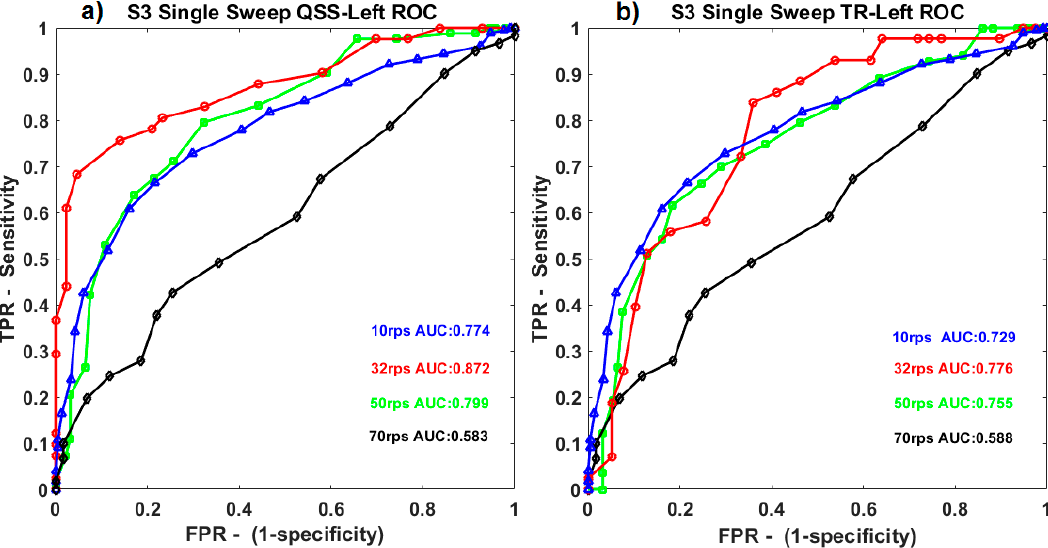
Figure 3. Subject 3 (S3) single sweep 0.5-second condition. ( a ) Left QSS-VEP receiver operating characteristic (ROC) curves and areas for all the rates are shown at the left. ( b ) Left TR-VEP ROC curves and areas for all the four rates are shown at the right.